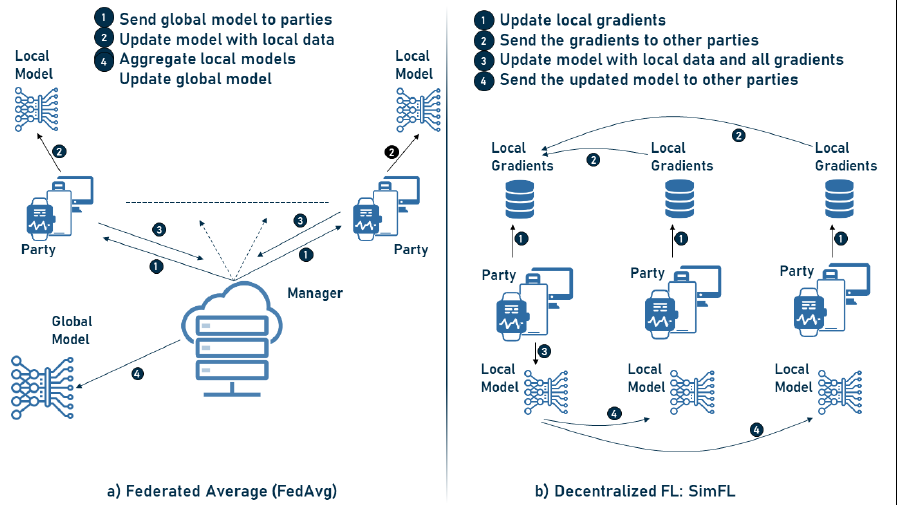
Figure 3. Communication–computation